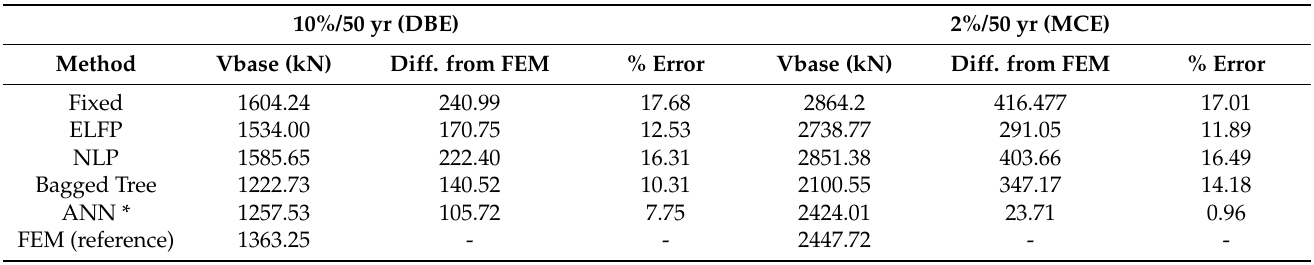
Figure 21. Comparison of MIDR obtained from different techniques. Table 5. Values of the base shear obtained from different techniques for the three-story mass irregularity structure.